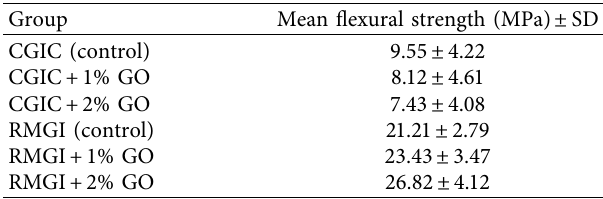
Table 2: Mean fexural strength values and corresponding standard